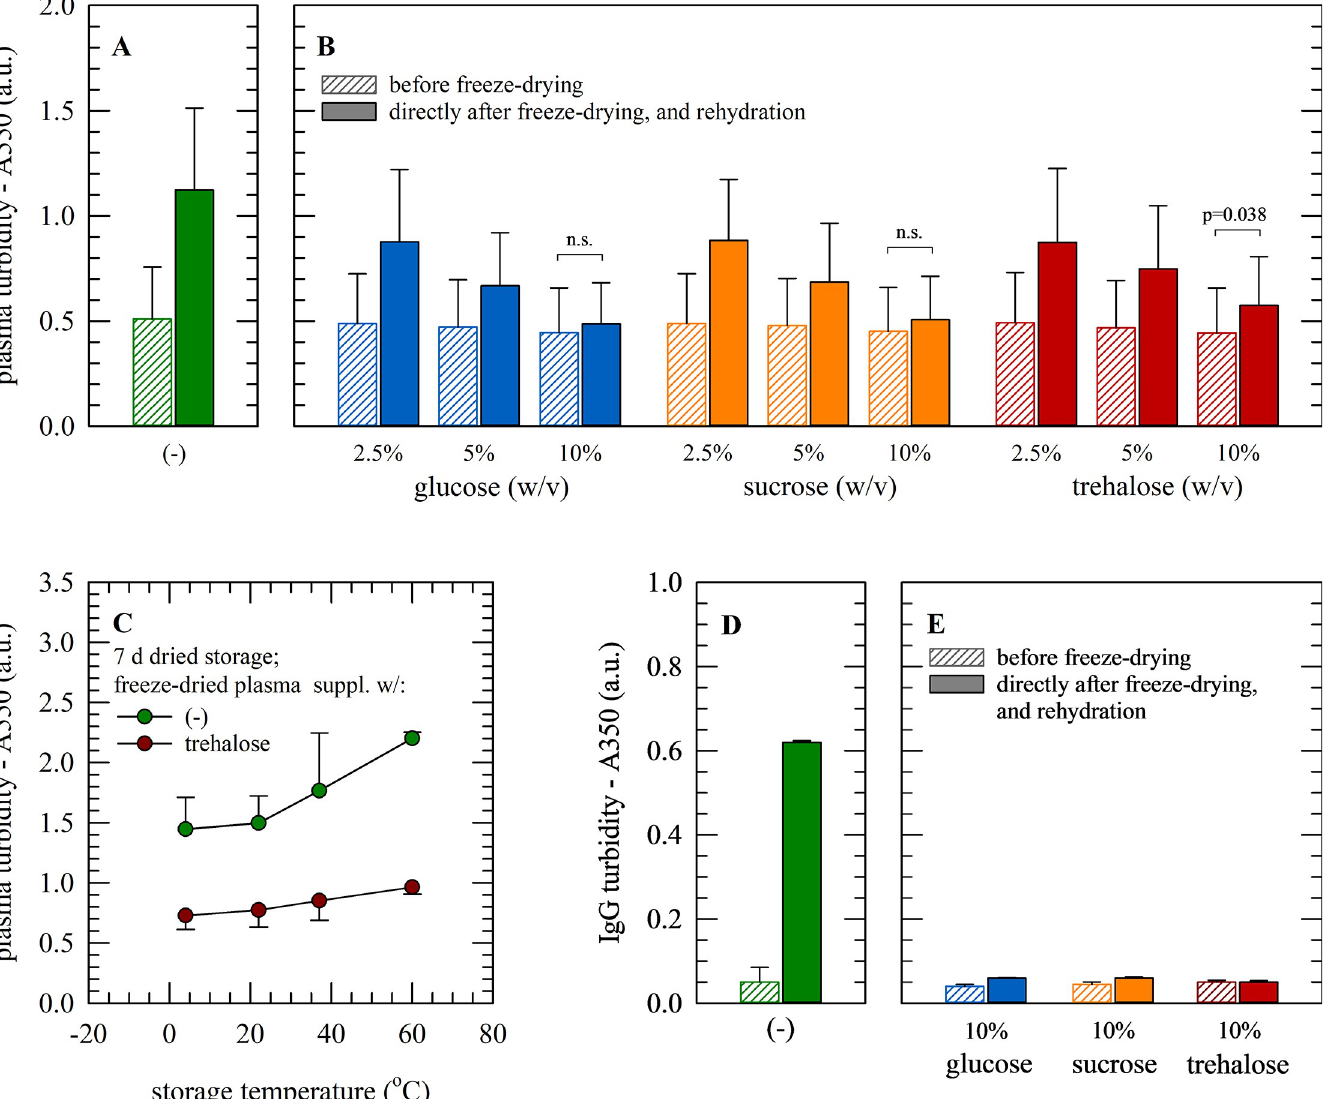
Fig 2. Turbidity of plasma after freeze-drying and rehydration. Human plasma (A − C) and pure IgG (D,E) were freeze-dried without (green) protectants as well as 2.5 − 10% glucose (blue), sucrose (orange) or trehalose (red). Samples were analyzed before (bars with diagonals) and directly after (filled bars) freeze-drying (A,B,D,E) or after 7 d dried storage at temperatures ranging from 4 − 60˚C (C). Protein aggregation was evaluated by means of turbidity as the absorbance at 550 nm (human plasma) or 350 nm (IgG). Mean values ± standard deviations are presented. For plasma, three technical replicates were performed for plasma obtained from six different donors. For IgG, measurements were done in triplicate.